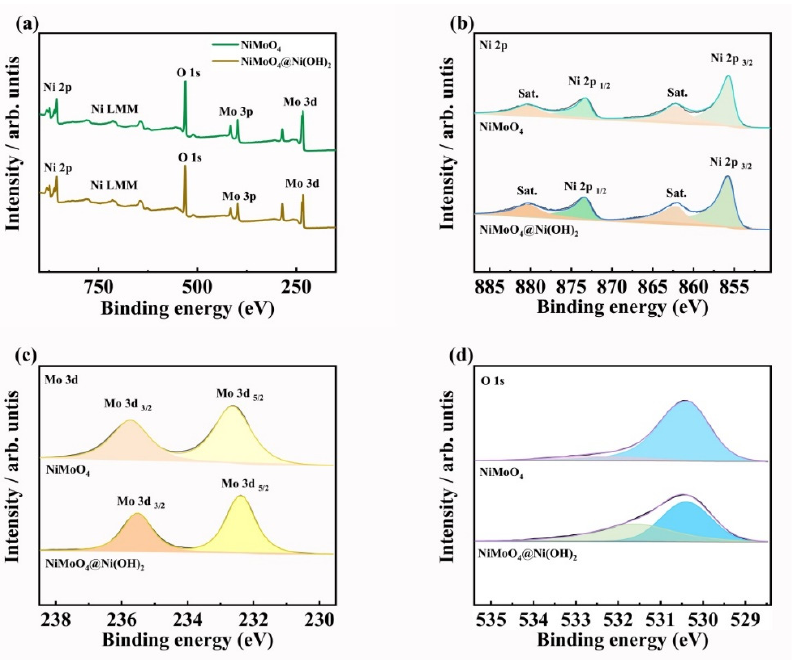
Figure 5. ( a ) XPS survey spectrum of NMO and NMH − 2. ( b ) Ni 2p, ( c ) Mo 2p and ( d ) O 1s. The electrochemical behaviors of NF, NMO, and NMH − 1,2,3 were determined in the three − electrode system in 2 M KOH. These electrodes were measured via CV, GCD, and EIS. As shown in Figure 6a, the potential window set from 0.05 to 0.45 V with the scan rate of 5 mV s − 1 of all the above materials, and the NMH − 2 displays the largest integrated